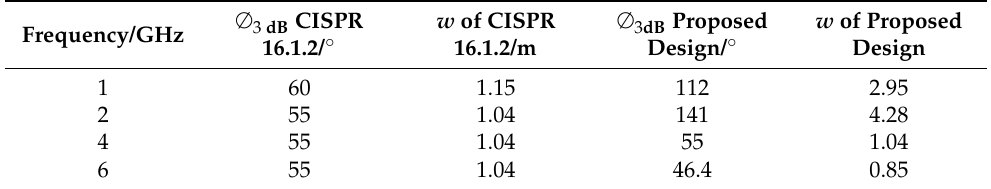
Table 7. Comparison between the minimum distance w in both CISPR 16.1.2 standard and proposed antenna at minimum measurement distance d = 1